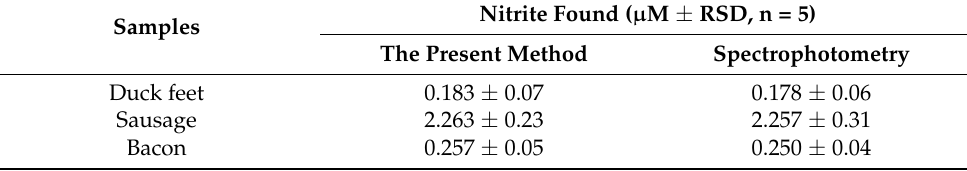
Table 2. Determination of nitrite in food